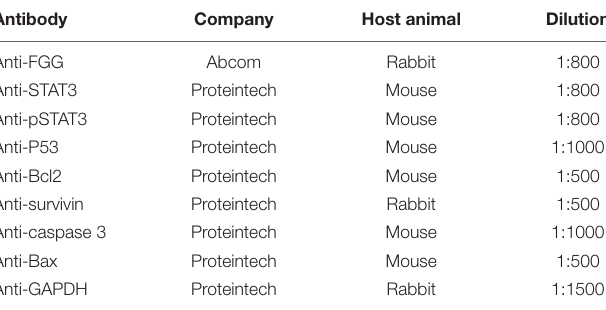
TABLE 2 | List of primers used for qRT-PCR. Gene Gene-specific primer pairs for quantitative